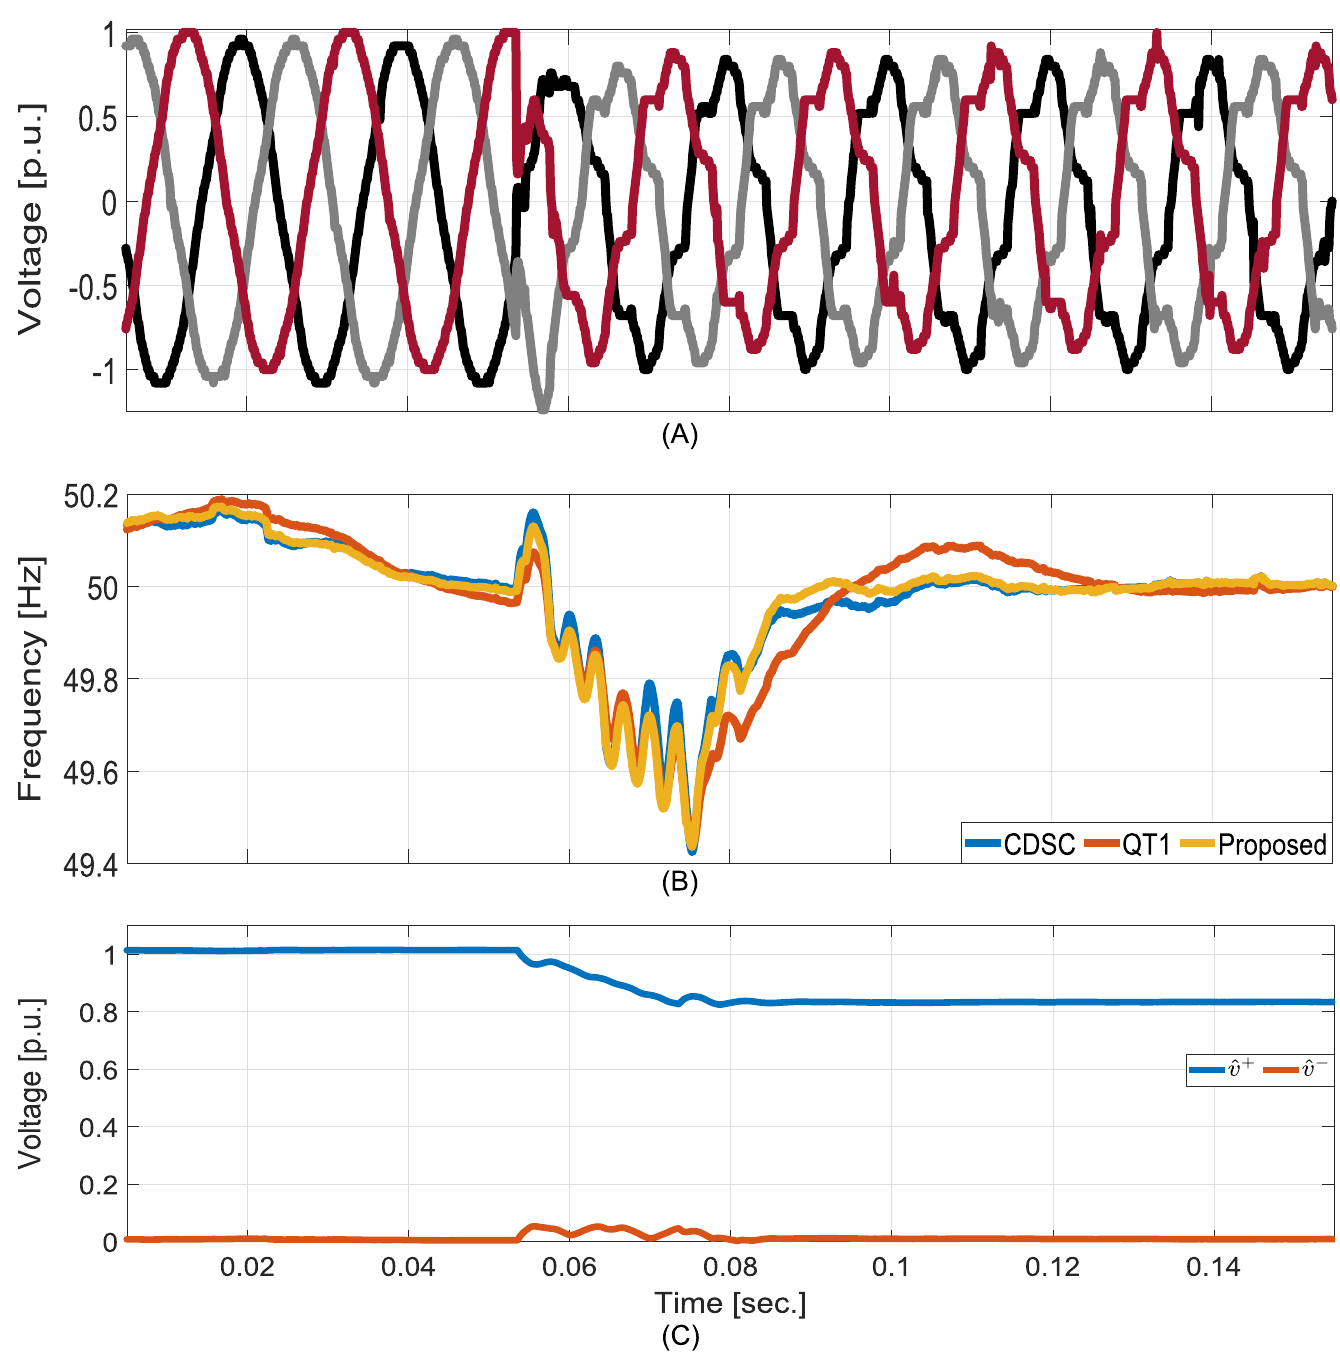
Fig 10. Comparative experimental results for nonlinear diode-rectifier load. A: Grid voltages. B: Estimated frequencies. C: Estimated FFPS and FFNS